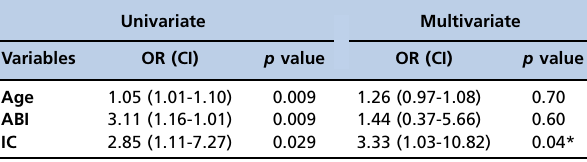
ABI: Ankle-brachial index; OR: odds ratio; CI: confidence interval; IC: intermittent claudication. *Adjusted for age, ABI, and IC.